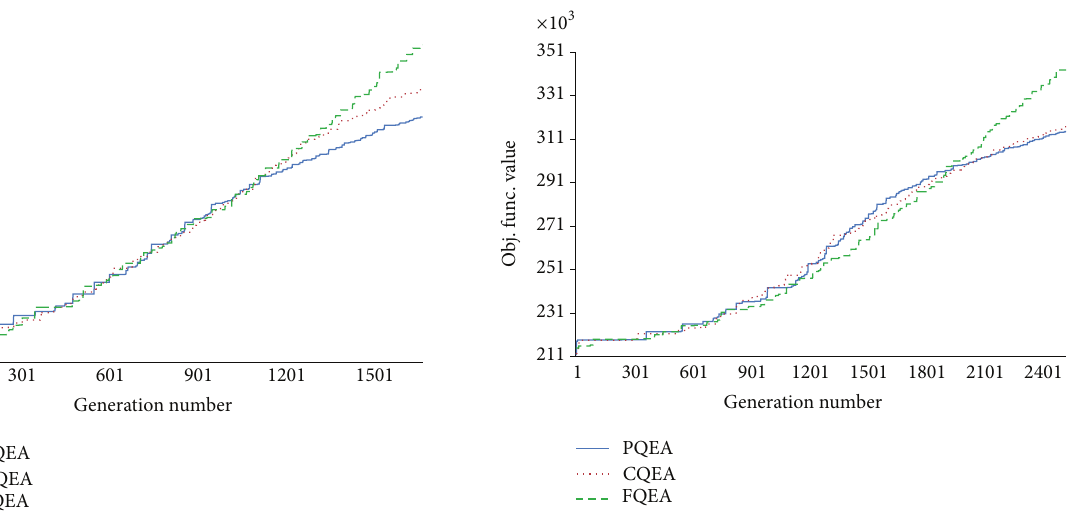
Figure 36: Convergence graph of PQEA, CQEA, and FQEA on 0-1 knapsack problem with circle data instances with number of items, 𝑀 , being 5000 and capacity, 𝐶 , being 10% of total weight.